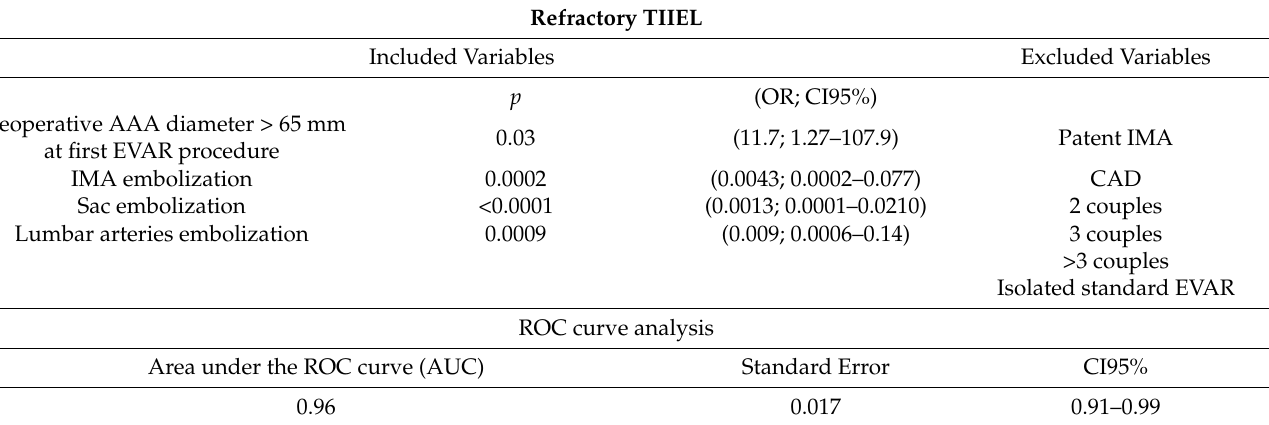
Table 6. Multivariate analysis (Backward method) on factor related to refractory TIIEL occurrence in present